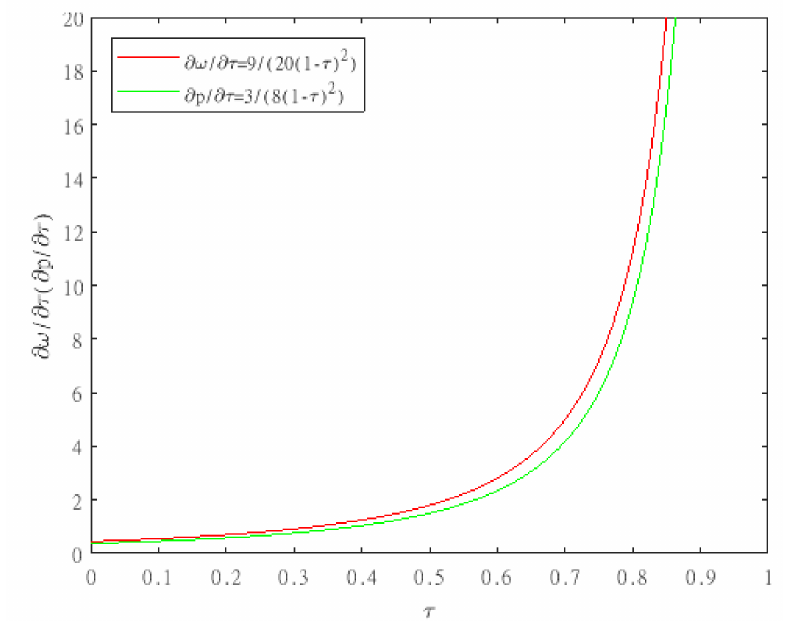
Figure 6. Price change rates for the intermediate and final products in response to ad valorem